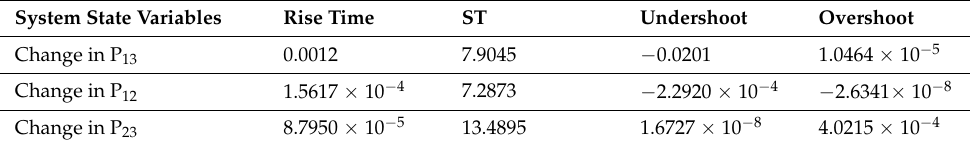
Table 7. Transient response of AGC tie-line power using DE+FPID+HVDC.